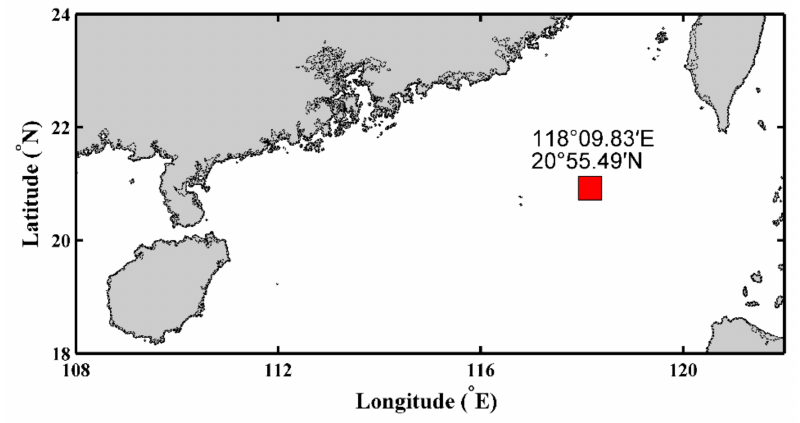
Figure 2. Deployment site, the location of the vertical profiler in SCS (red